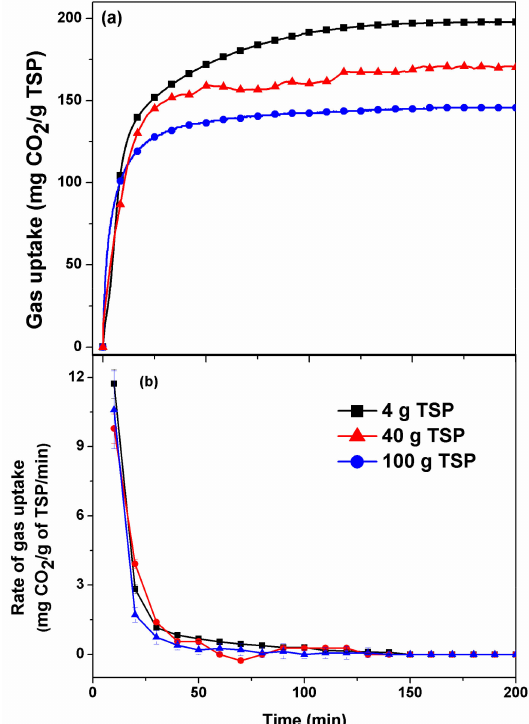
Figure 9. ( a ) Comparison of CO 2 capture capacity measured at small and larger scales in which 40 g and 100 g of TSP was used for large scale and 4 g for a small scale; ( b ) rate of gas uptake (mg of CO 2 / g of sorbent / min) for the same system (Curves provided to guide the